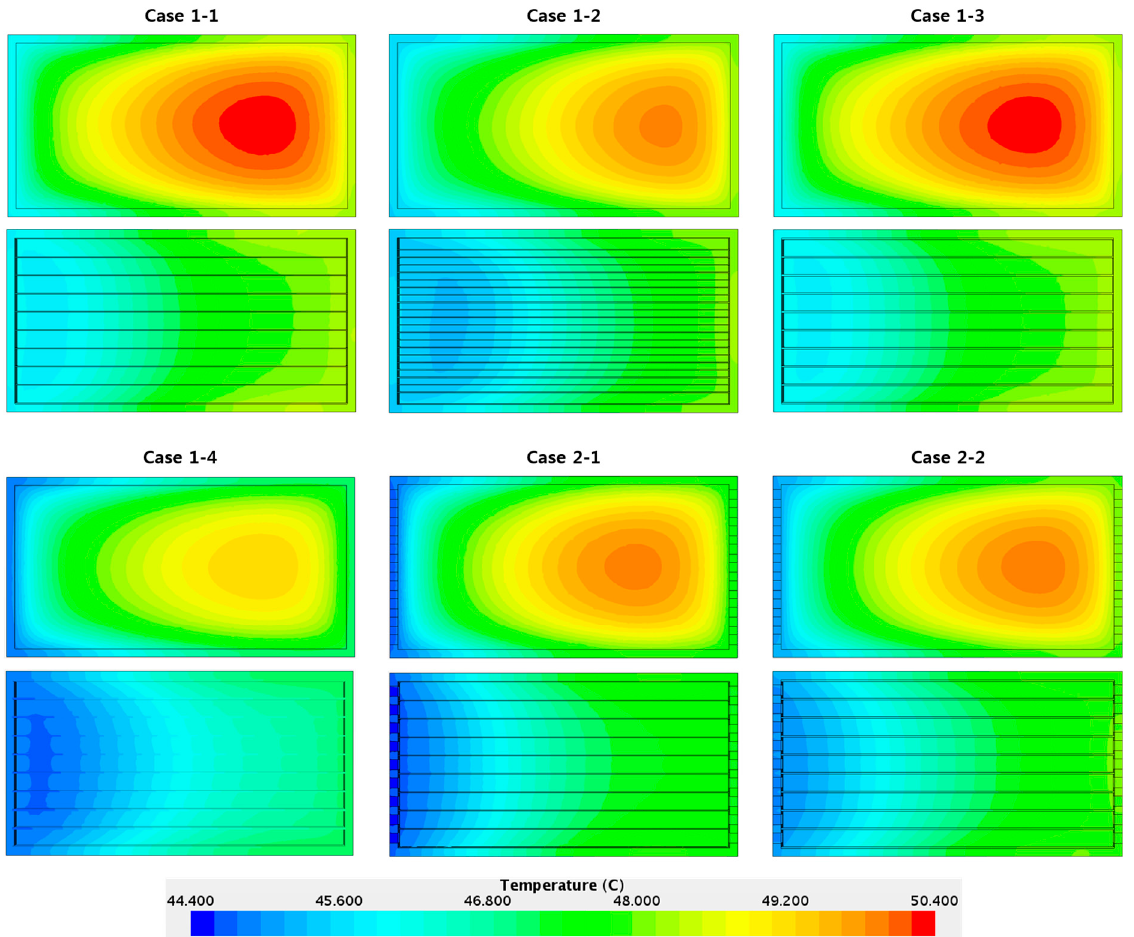
Figure 8. Velocity distribution of the cases with cooling.